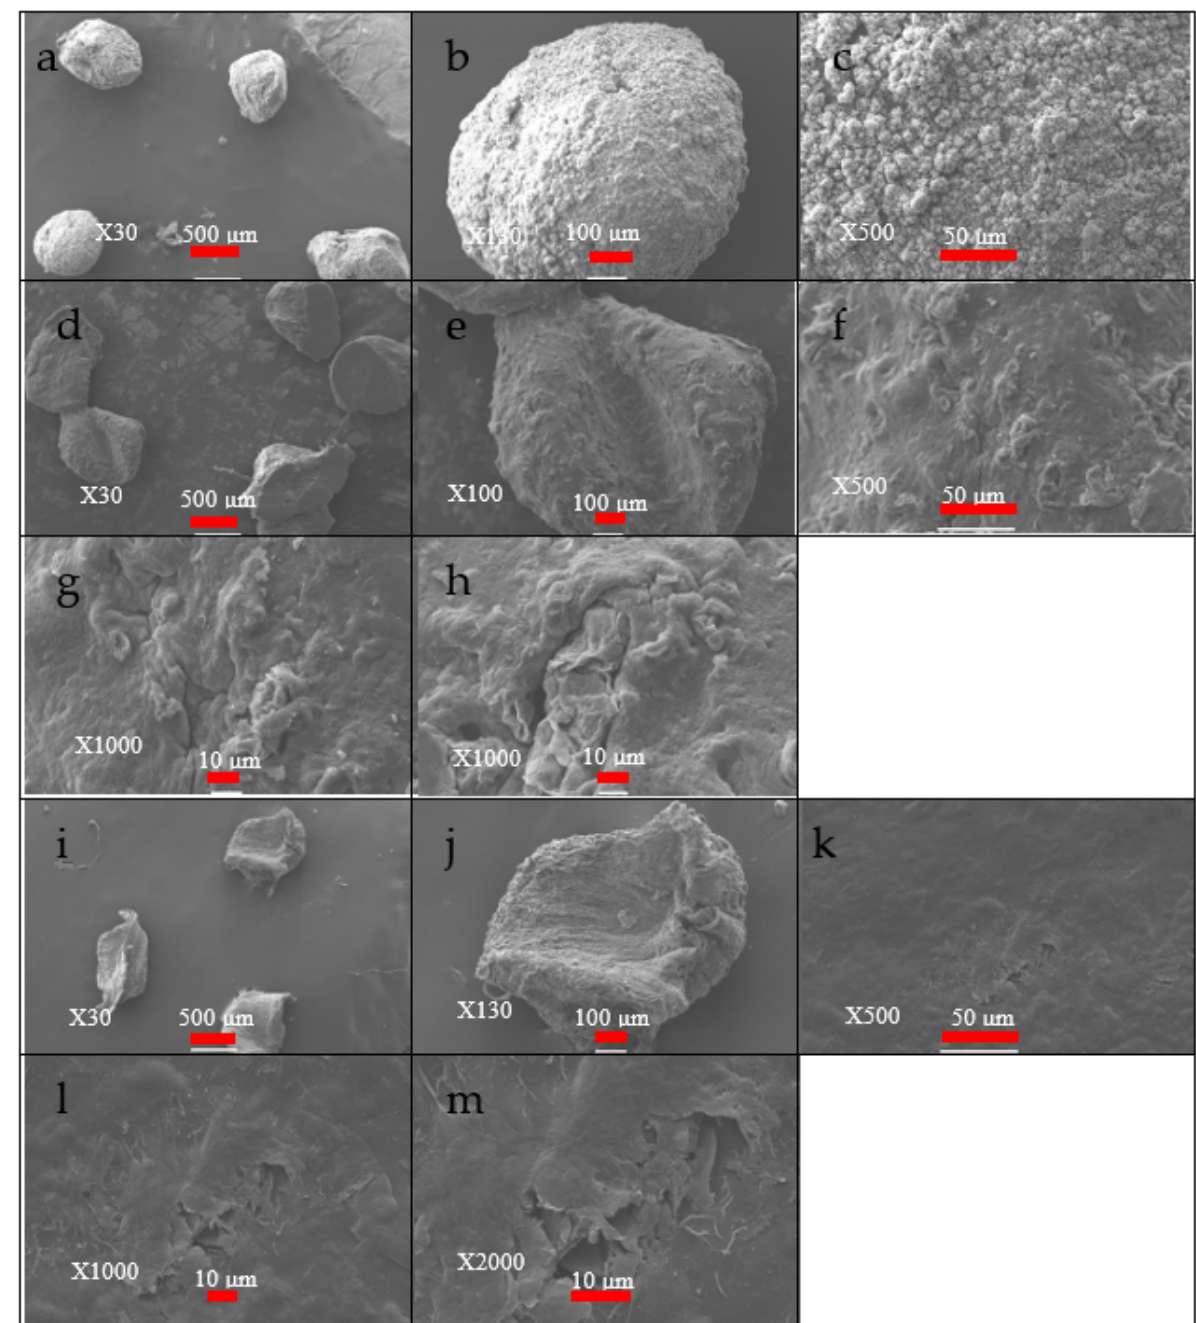
Figure 3. SEM images of, ( a – c ) the GO@CS beads, ( d – h ) the GO@CS beads after one cycle use, and ( i – m ) the GO@CS beads after five cycle use.